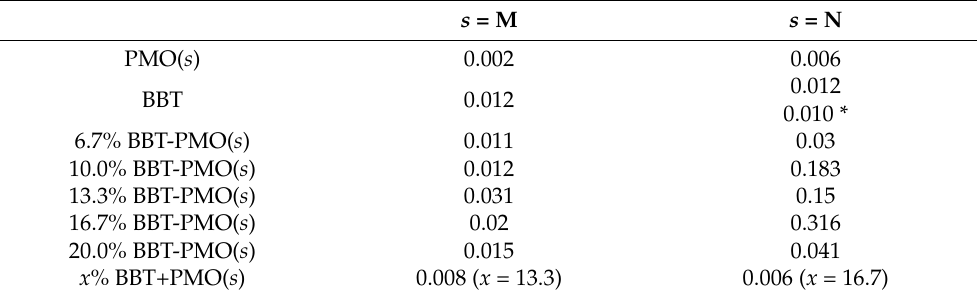
Table 1. The reaction rate constants ( k obs (min − 1 )) for Cr(VI) photocatalytic reduction on different photocatalysts, which was determined by the first-order kinetic model. s =